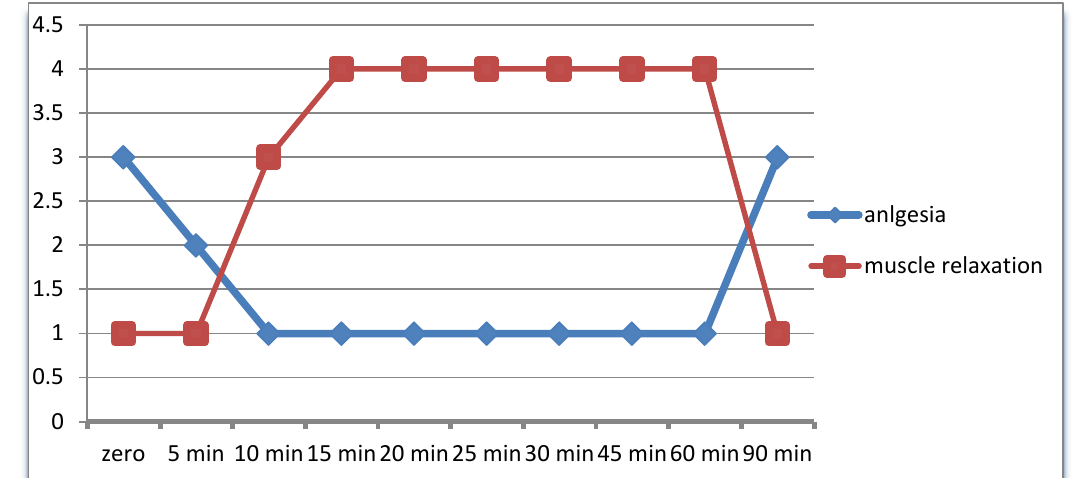
Diagram: Degree of analgesia and muscle relaxation through general anesthesia of